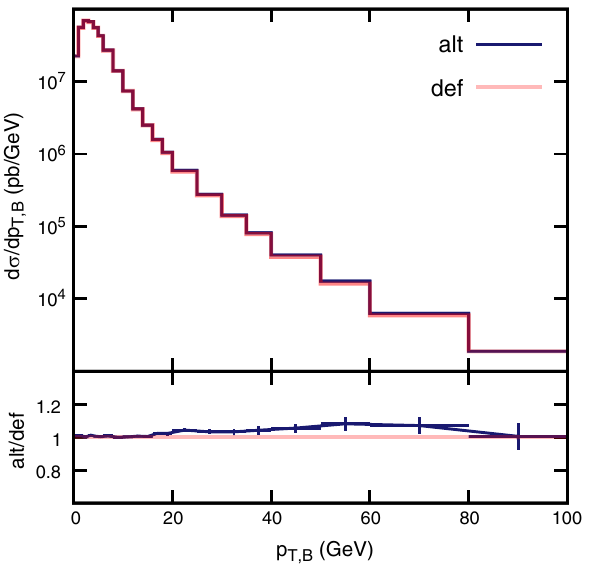
Fig. 10 Comparison of alt and def for the b -jet mass jet masses above 10 GeV the gluon splitting configuration